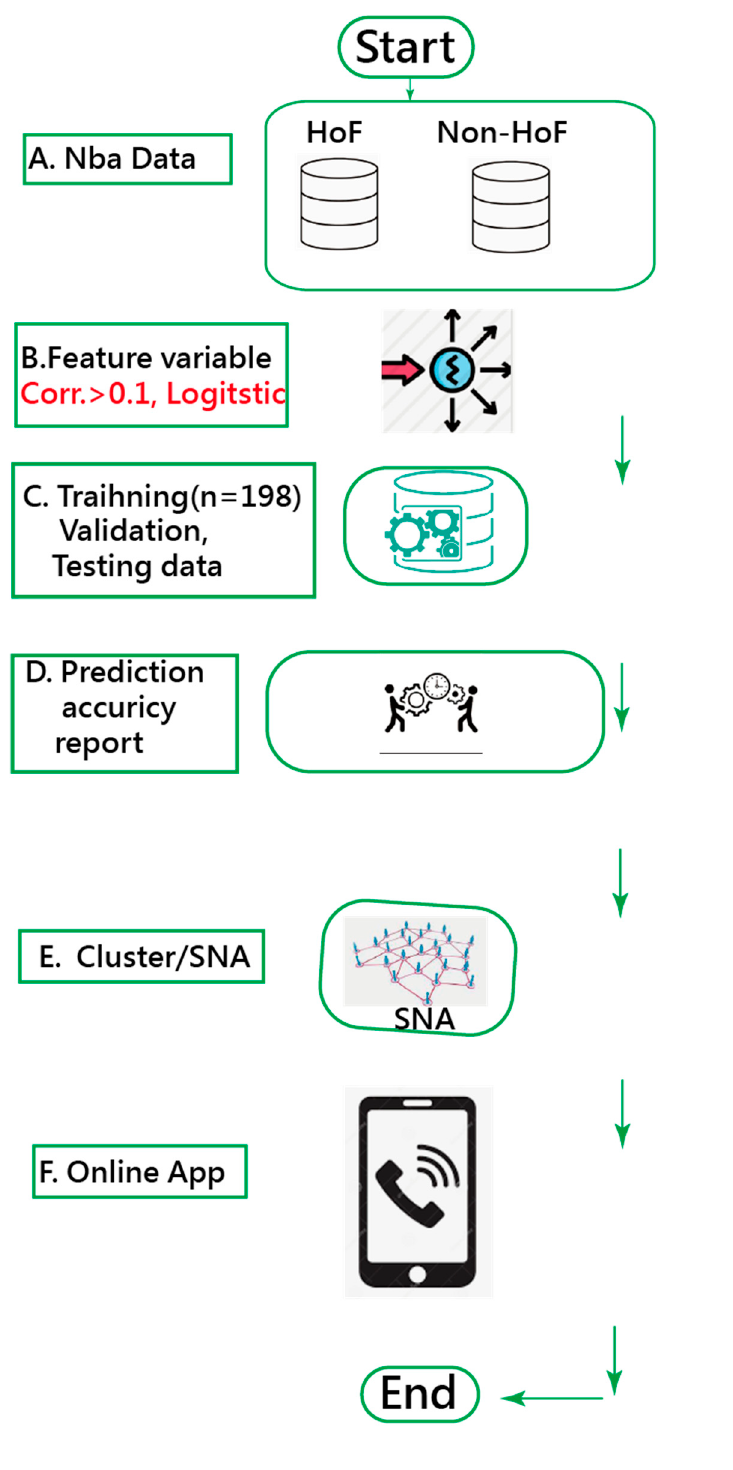
Figure 2. The study flowchart.